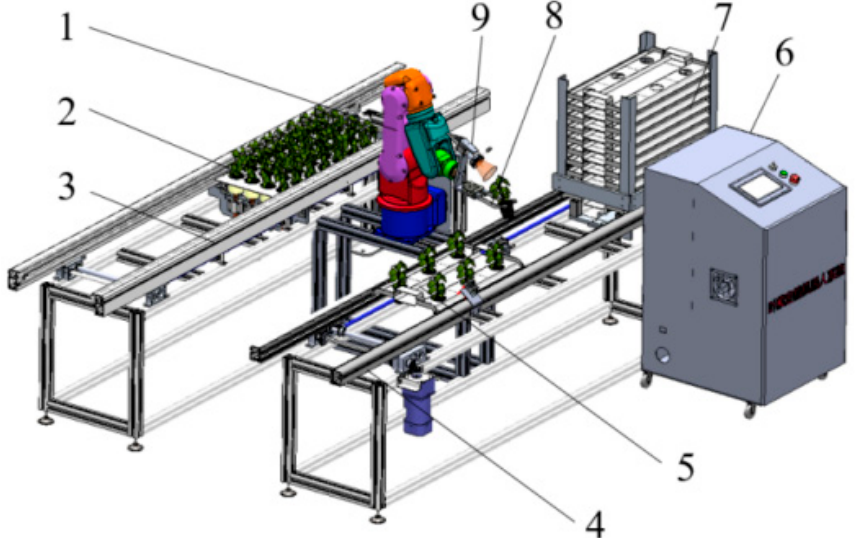
Figure 1. Leafy vegetable transplantation robot: 1. Handling robot. 2. Seedling tray. 3. Seedling tray conveyor. 4. Transplanting plate conveyor. 5. Transplanting plate. 6. Control cabinet. 7. Transplanting plate lower plate mechanism. 8. Transplanting actuator. 9. Vision system.